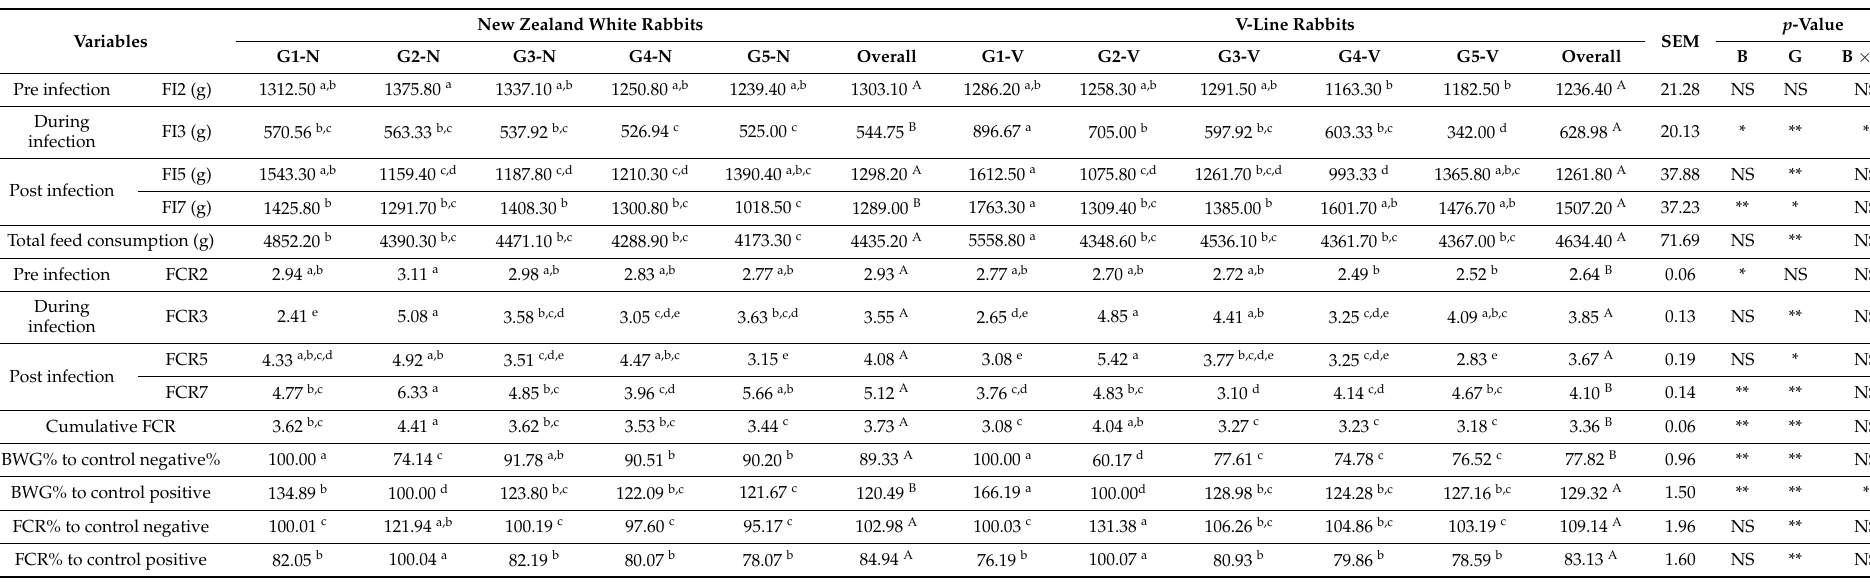
Table 2. Feed intake and feed conversion rate changes of the New Zealand white and V-line rabbits in response to coccidial infection and herbal extract